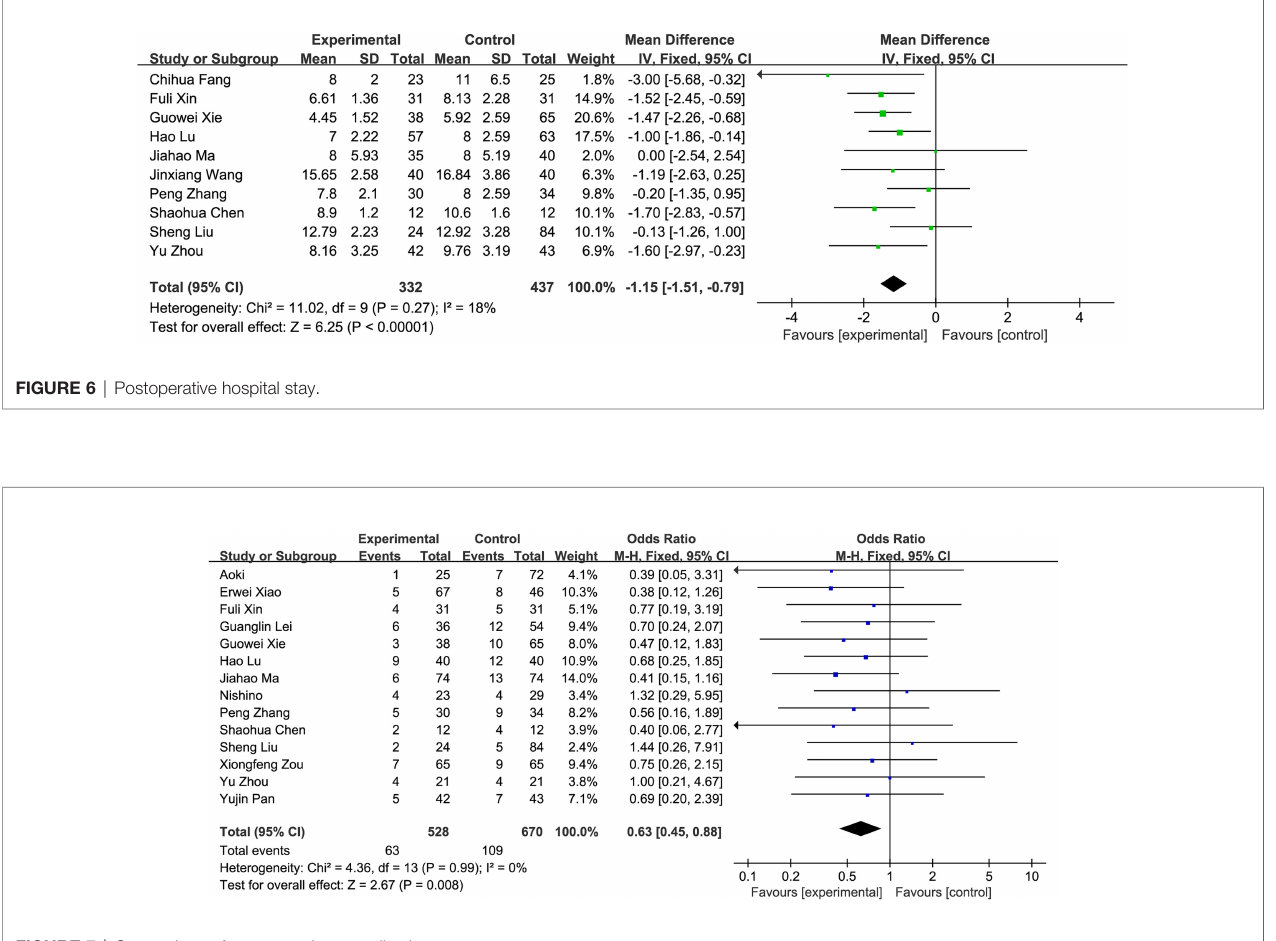
FIGURE 7 | Comparison of postoperative